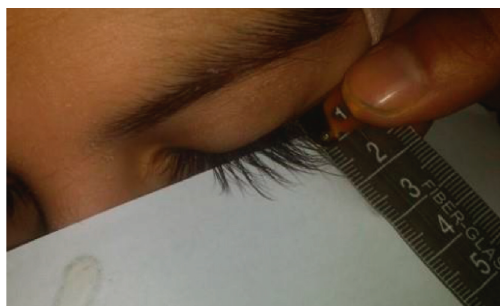
Figure 2: Eyelash trichomegaly in SLE